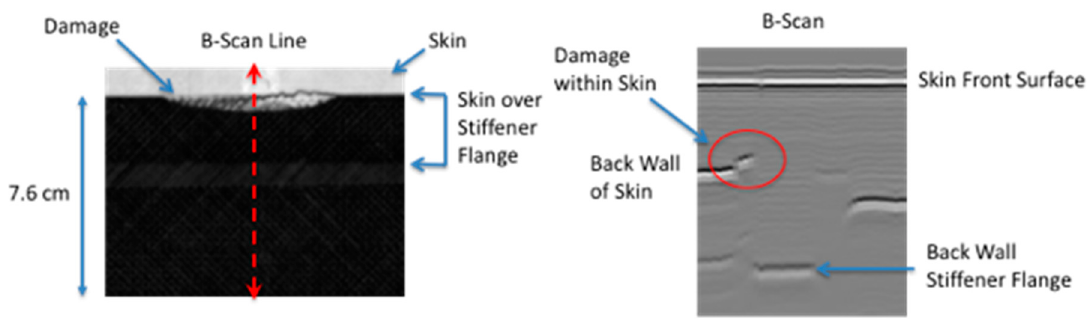
Sensors 2018 , 18 , 3562 Figure 14. Ultrasonic data to estimate damage depth for small area damage. Figure 14. Ultrasonic data to estimate damage depth for small area damage.